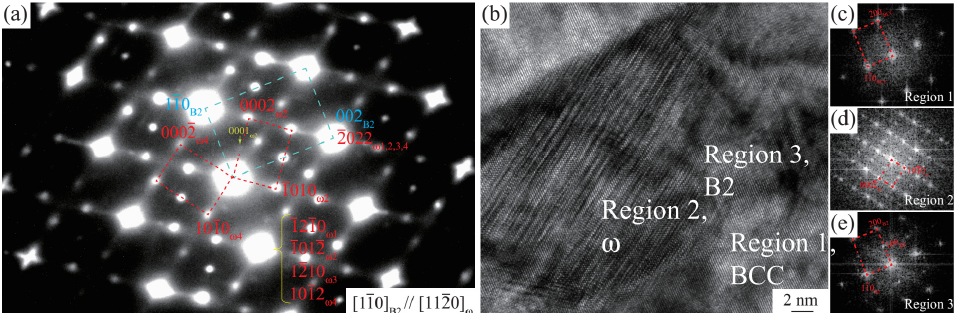
Figure 4. ( a ) Selected-area diffraction (SAD) pattern obtained from the matrix in the quenched Ni45.98-Ga25.50-Cr28.52 alloy after annealing at 1150 °C for 10 days. ( b ) High-resolution transmission electron microscopy (HRTEM) image obtained from the quenched Ni42.23-Ga15.70-Cr42.07 alloy after annealing at 1150 °C for 10 days. ( c – e ) Fast Fourier Transforms (FFTs) of regions 1, 2 and 3 in ( b ).